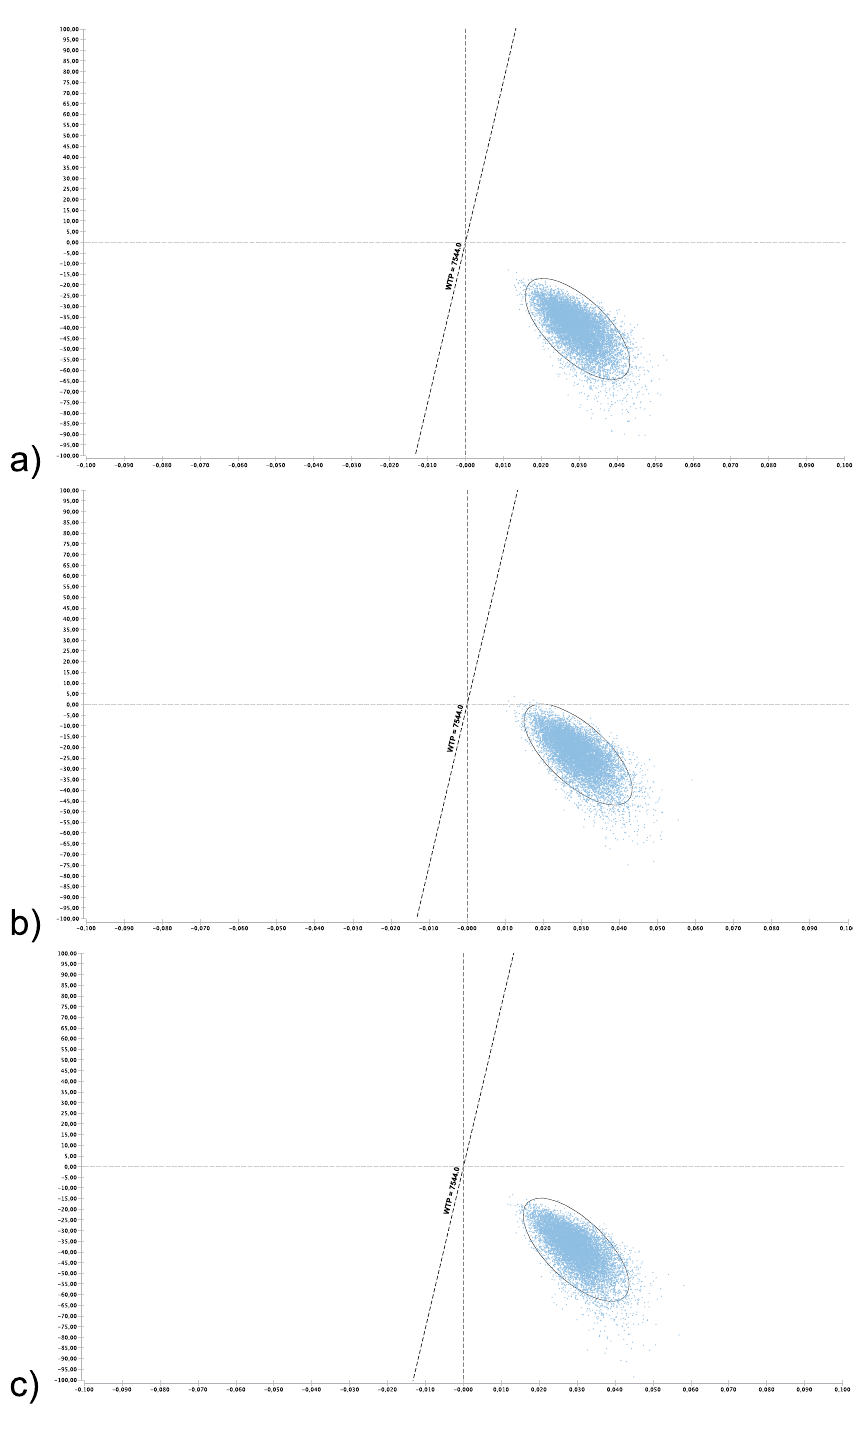
Figure 1. ( a – c ) Incremental cost effectiveness scatter plot of ( a ) Diaskintest vs. TST; ( b ) QFT-Plus vs. TST; ( c ) EC skin test vs. TST. Costs in 2020 US$ and effectiveness in QALYs. The graphs show the scatter plot of the resulting incremental cost-effectiveness ratio of 10,000 Monte Carlo simulations for the different strategies compared with tubeculin skin test. The diagonal line represents the willingness to pay threshold of US $7544. Values on the right lower quadrant are cost saving (less costly and more effective). The X-axis is scaled from − 0.1 to 0.1 QALY and Y-axis from − 100 to 100 US$. TST tuberculin skin test, QFT-Plus QuantiFERON-TB Gold